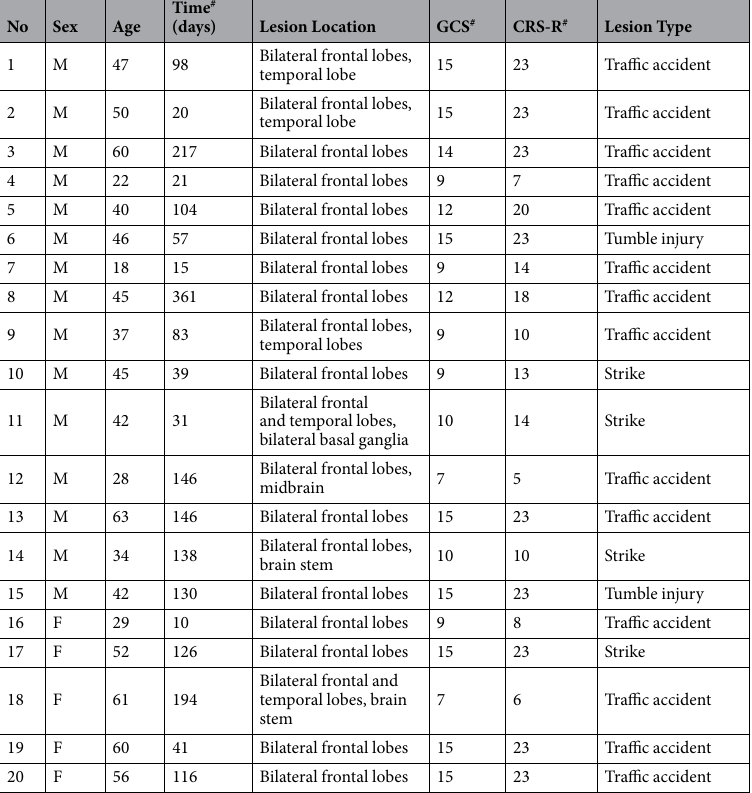
Table 1. Patient Information. The mean interval between MR imaging and trauma = 109.25 days (range 20~361 days). GCS and CRS-R assessments were conducted immediately before radiological tests. P.S.: Time # : The time from the day of injury to fMRI scanning day; GCS # , CRS-R # : Glasgow Coma Scale and Coma Recovery Scale- Revised